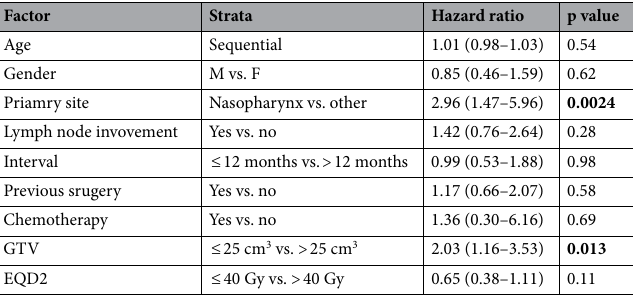
Table 2. Multivariate analysis for overall survivai rate. Significant values are in